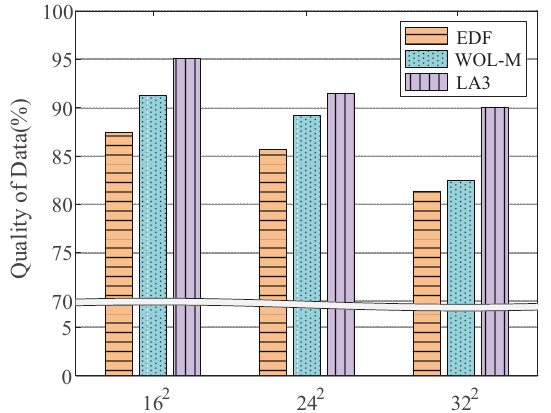
Figure 16. Performances test with a state-of-the-art